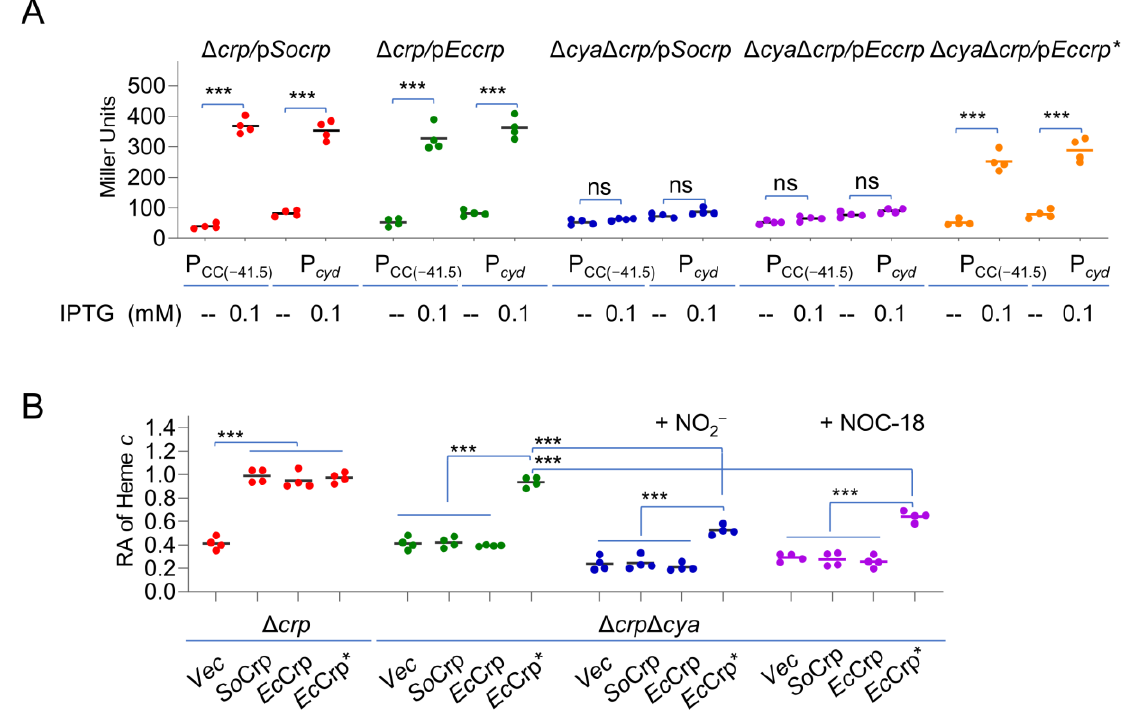
Figure 3. cAMP-CRP is not exclusively responsible for the nitrite-/NO-mediated reduction in the cyt c content. ( A ) Ec Crp T128L-S129I (encoded by Eccrp *) is independent of cAMP in S. oneidensis . Production of So Crp, Ec Crp, and Ec Crp T128L-S129I was driven by the IPTG-inducible promoter in the S. oneidensis crp and crp - cya (missing all enzymes for cAMP synthesis) mutants. P CC( − 41.5) and P cyd are promoters that are directly controlled by Ec Crp and So Crp, respectively. Promoter activity in cells grown to the early stationary phase was determined by LacZ reporters. ( B ) Heme c levels in the S. oneidensis crp and crp - cya mutants producing So Crp, Ec Crp, and Ec Crp T128L-S129I with IPTG at 0.1 mM. Effects of 5 mM nitrite and 0.1 mM NOC-18 on Ec Crp T128L-S129I were compared. Vec, empty vector. Asterisks indicate statistically significant difference of the values compared ( n = 4; ns, not significant; ***, p < 0.001).